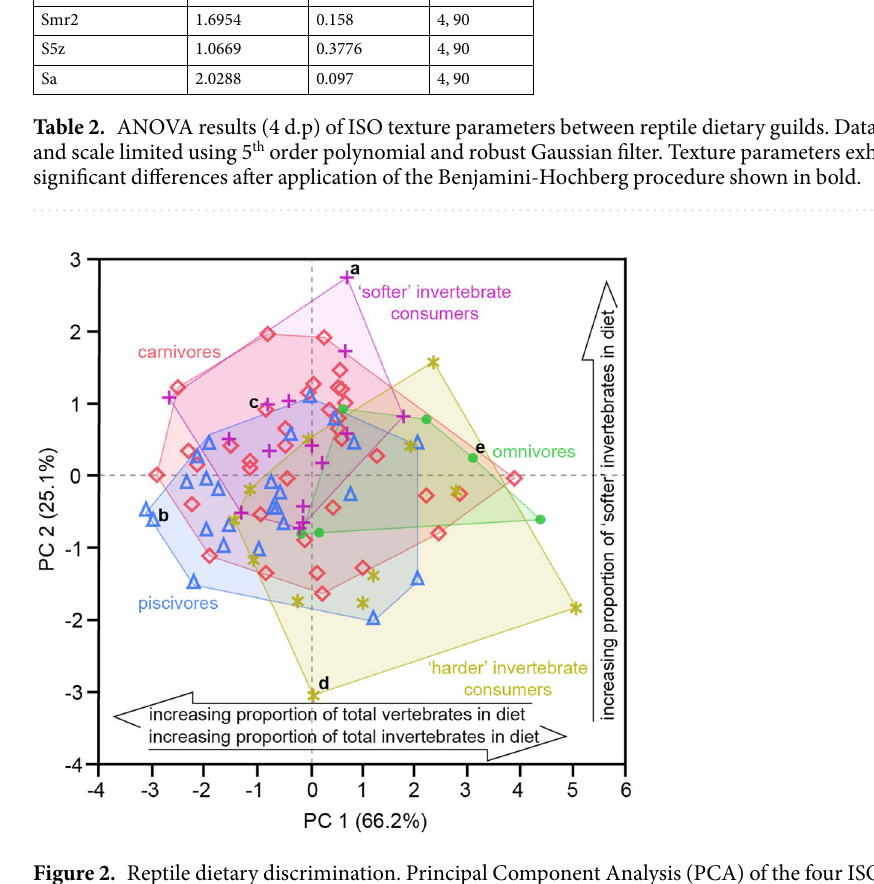
Figure 2. Reptile dietary discrimination. Principal Component Analysis (PCA) of the four ISO texture parameters (Spk, Sds, Vmp and Smr1) that distinguish reptile dietary guilds. ( a – e ) indicate the examples of scale limited textures illustrated in Fig. 1. Arrows show significant correlations of dietary characteristics along PC axes 1 and 2. For full parameter definitions and details of all dietary correlations along PC axes 1 and 2, see the Supplementary